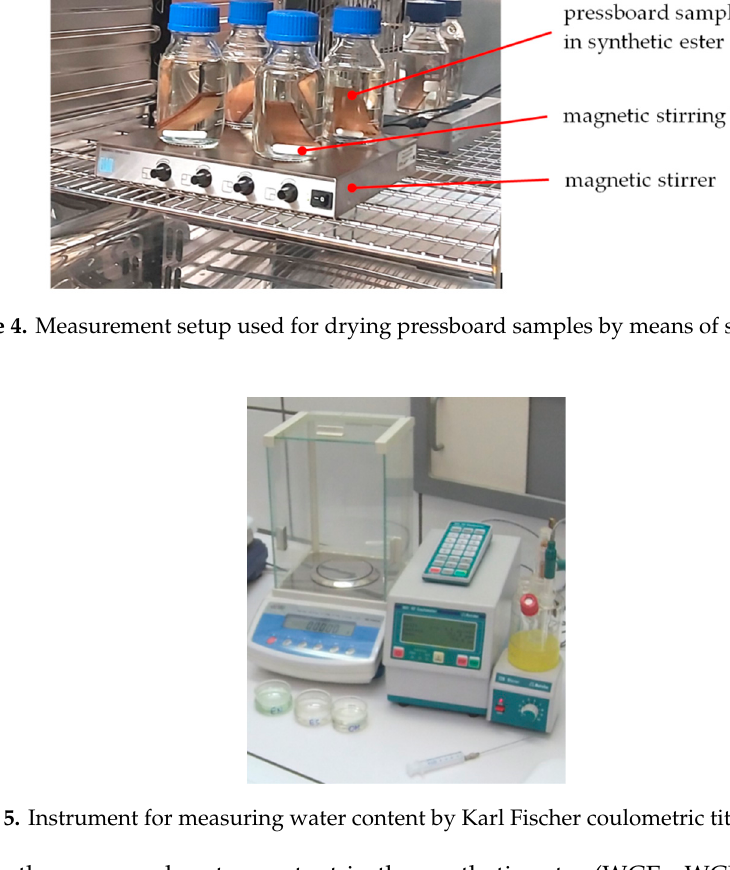
Figure 5. Instrument for measuring water content by Karl Fischer coulometric titration method.